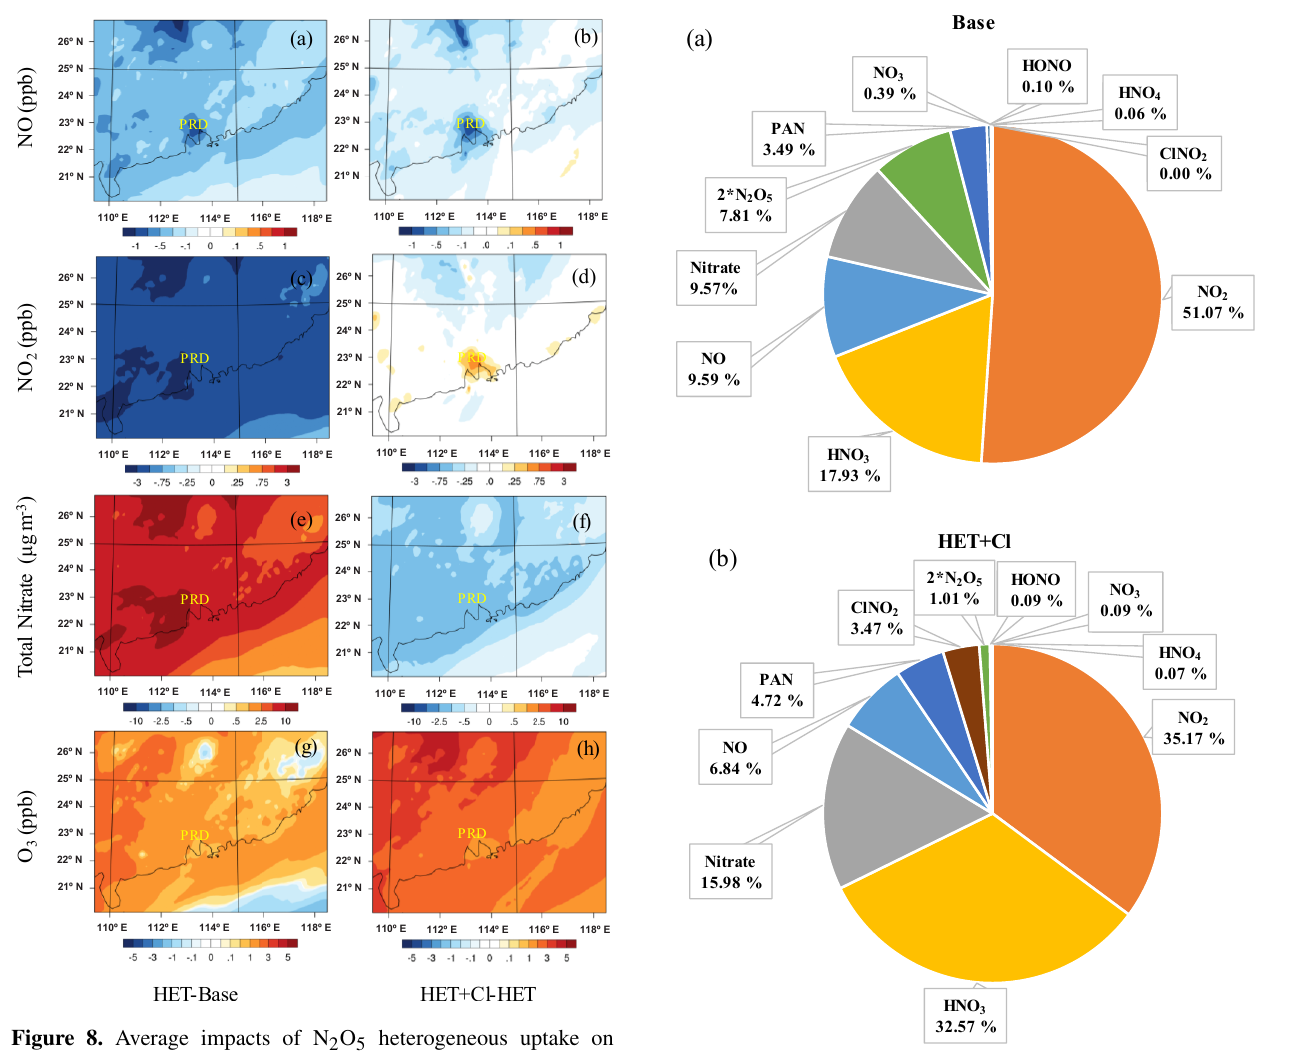
Figure 9. Average NO y partitioning during the study period in southern China within the PBL as simulated in (a) the base case and (b) the HET + Cl